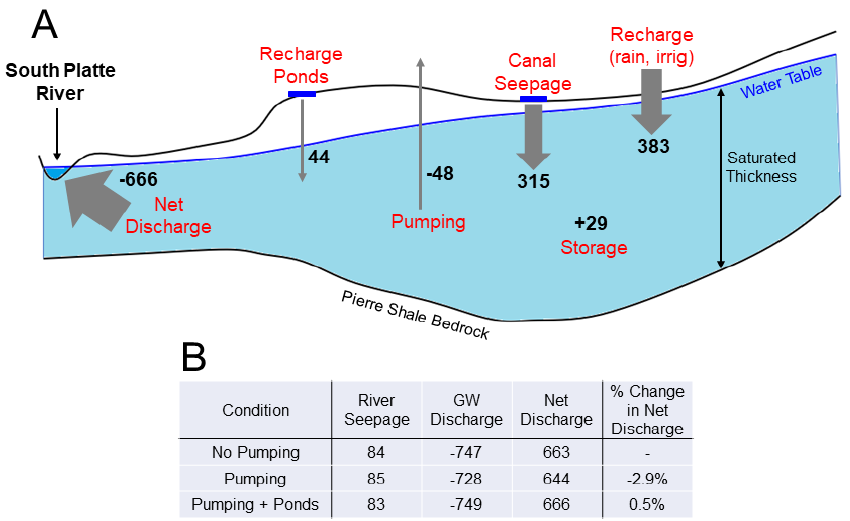
Figure 13. ( A ) cross-section schematic of the model region, showing flux magnitudes for groundwater sources and sinks; ( B ) table showing net discharge for the three scenarios.